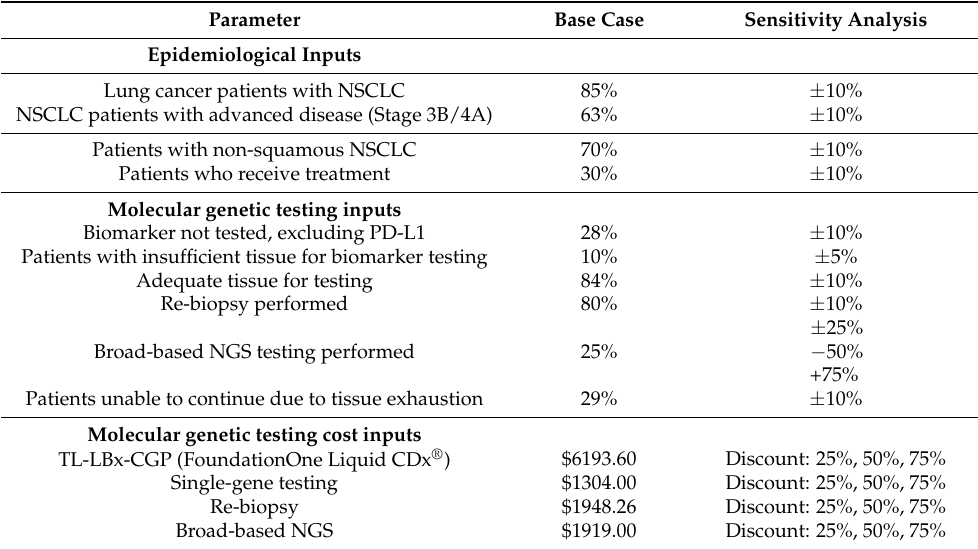
Table 6. Health outcomes data.